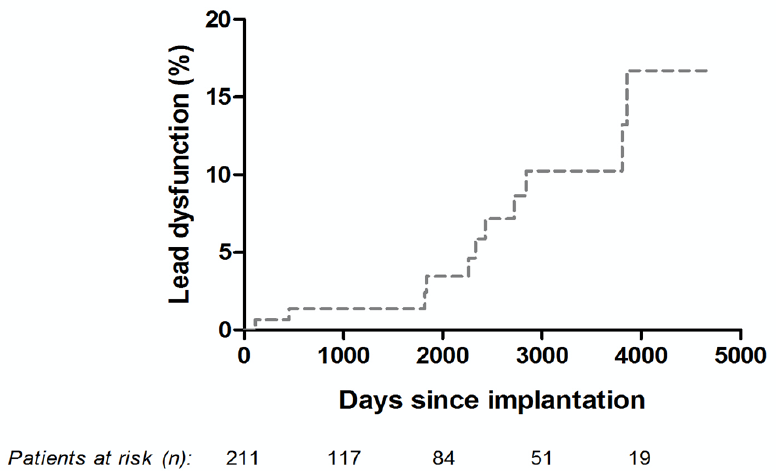
Figure 2. Kaplan-Meier curve describing the prevalence of dysfunction of the Osypka QT-5 ® ventricular lead.